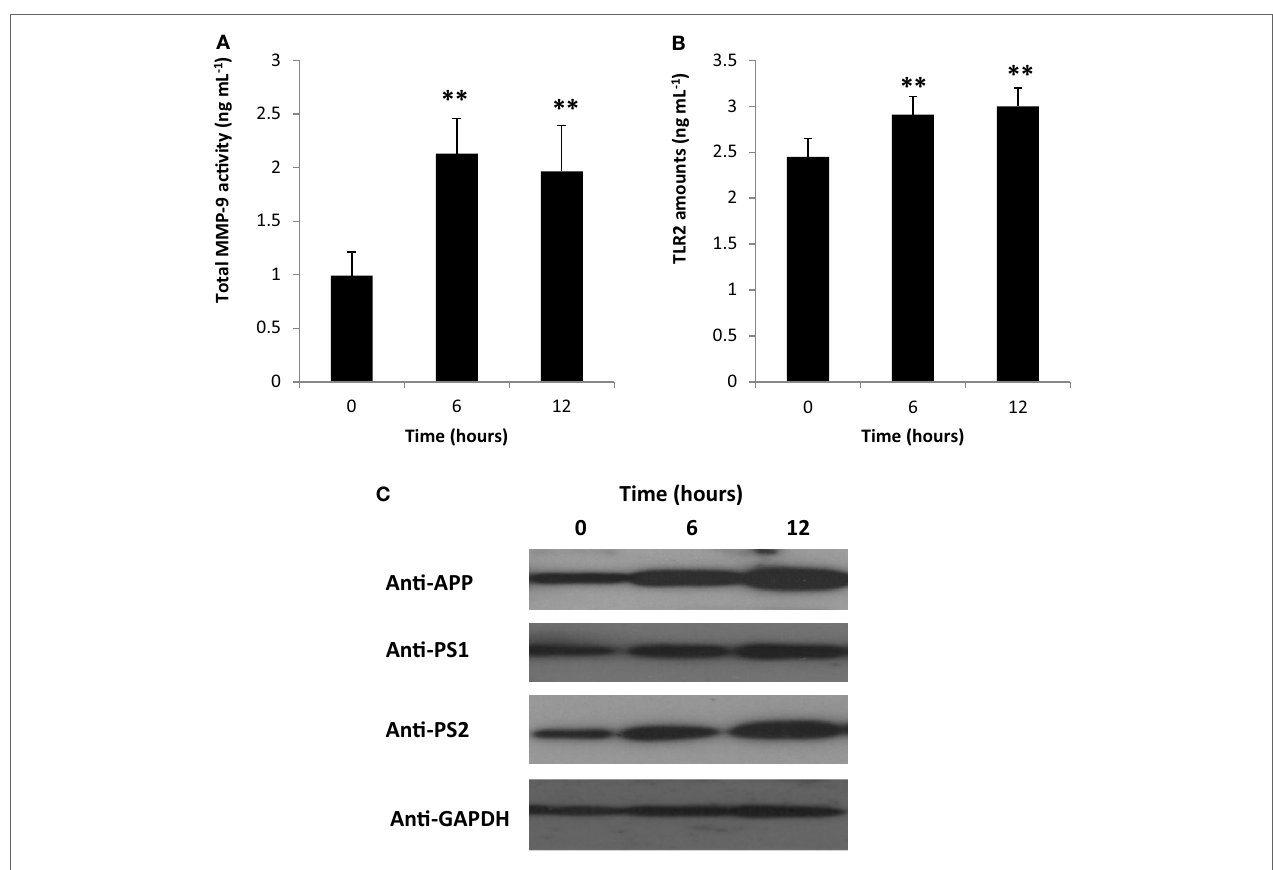
FigUre 3 | Gingival periodontal diseases level-butyric acid (BA) affected matrix metalloproteinases (MMP)-9-modulated inflammation affected representative neurological blood biomarkers. Quantification of blood cytosolic (a) MMP-9 activity and (B) toll-like receptor-2 (TLR2) amounts are indicated. Results shown are mean ± SE utilizing independent samples (collected at 0, 6, and 12 h post-treatment with BA) of 10-week-old Wistar male rats ( n = 6). Statistical analyses were performed using Anderson–Darling normality test and, if passed ( p > 0.05), Student’s t -test (** p < 0.01). (c) Western blotting data of representative blood biomarkers. Antibodies used to detect amyloid precursor protein (APP), presenilin-1 (PS1), preseinilin-2 (PS2), and glyceraldehydes-3-phosphate (GAPDH) are